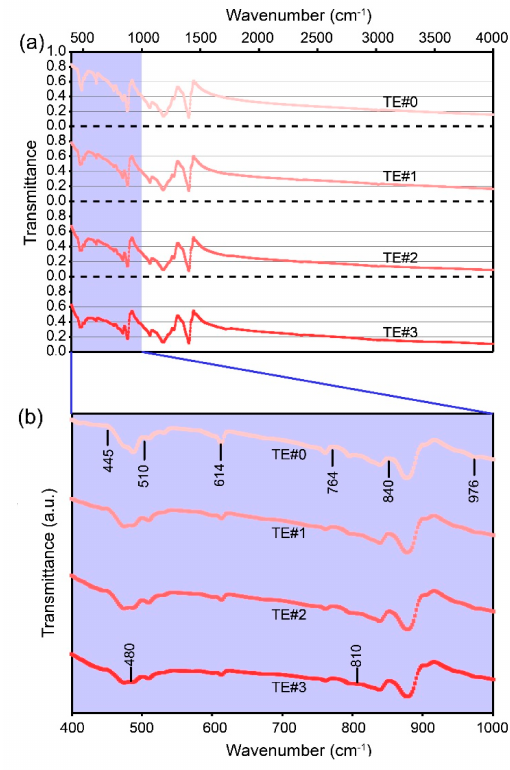
Figure 7. Transmittances for different self-assembly cycles. ( a ) At wavenumbers 400–4000 cm − 1 ; ( b ) 400–1000 cm − 1